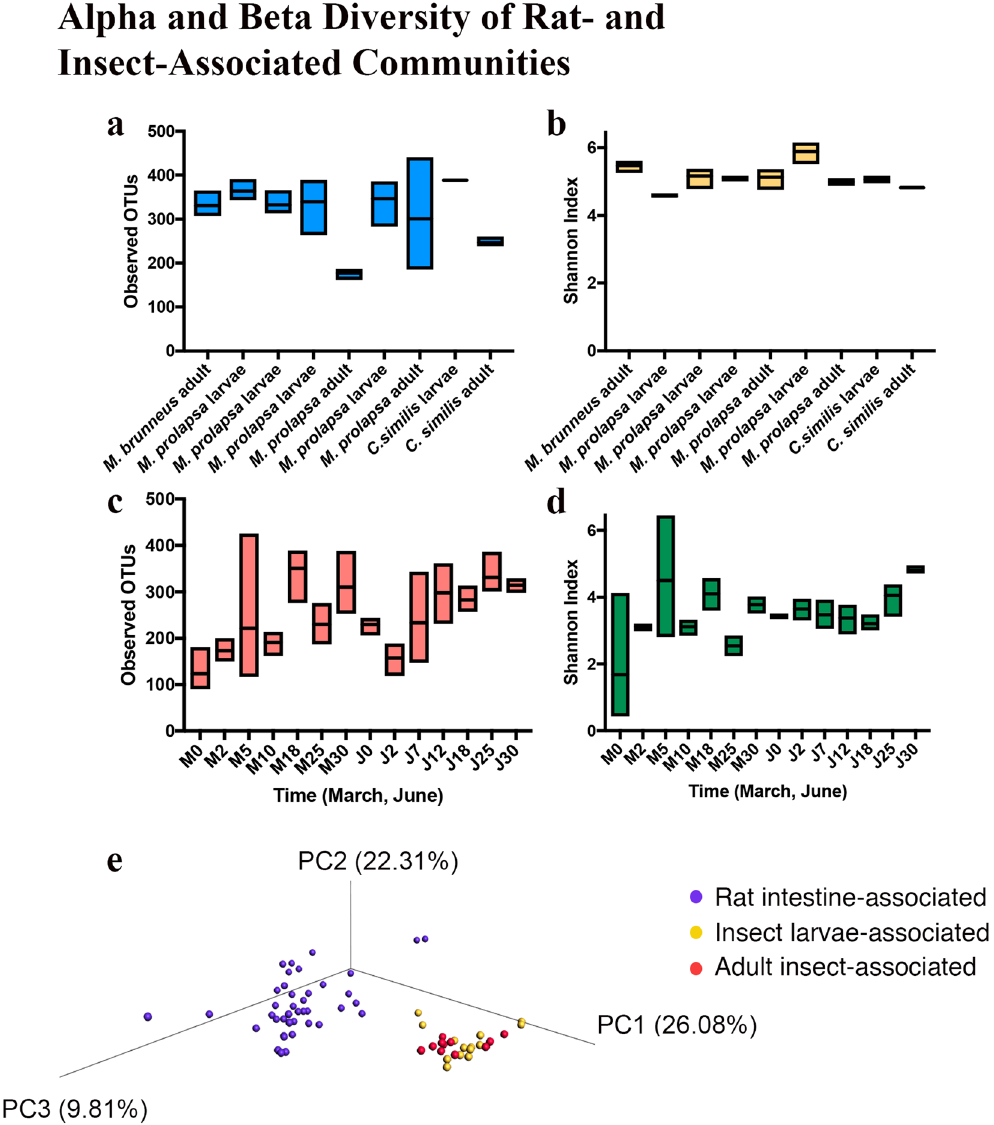
Figure 7. Alpha diversity represented by OTU richness and Shannon’s Diversity Index for insect–associated ( a , b ), and rat intestine–associated ( c , d ). Beta diversity of decomposition microbiome based on weighted UniFrac distances ( e